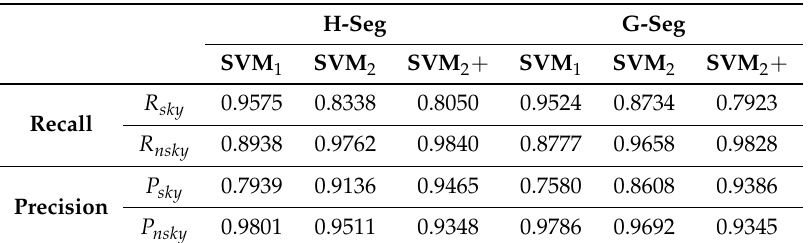
Table 1. Recall and precision of SVM 1 , SVM 2 and SVM 2 +